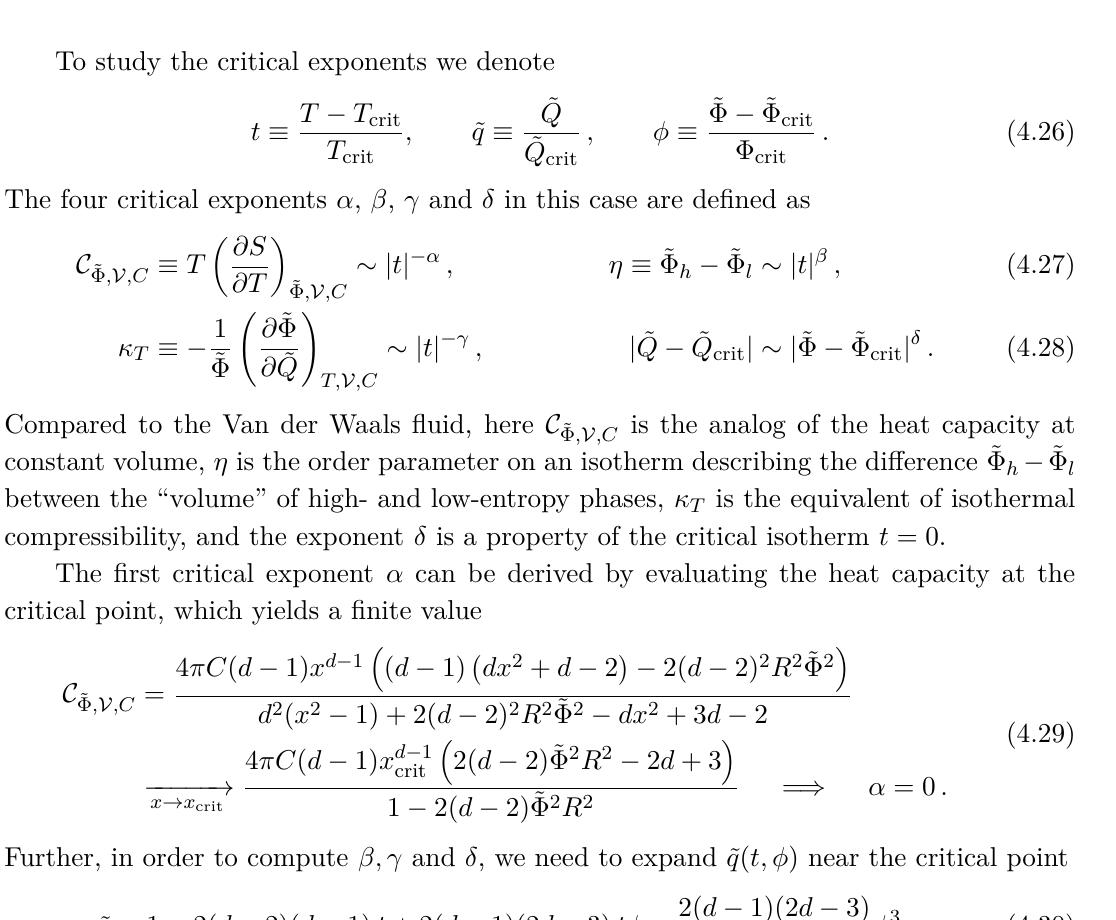
Figure 8 . Isotherms in the parameters used here are C = R = 1 and T = 0 . 999 T T = 1 . 001 T crit (green) and T = 1 . 002 T crit (red). For the temperatures T < T crit , the displays a “wriggle” for which Maxwell’s equal area law